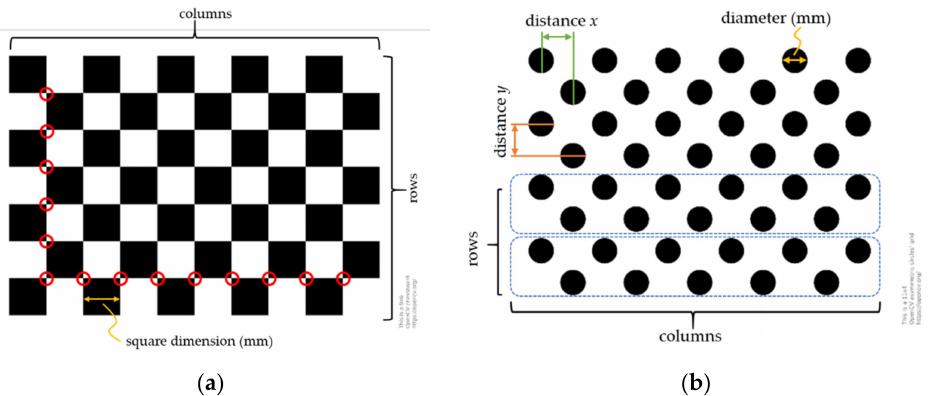
Figure 8. The most employed patterns for camera calibration. ( a ) A 7 rows × 10 columns checkerboard pattern. The calibration uses the interior vertex points of the checkerboard pattern; thus, the checkerboard in ( a ) will utilize the 6 × 9 interior vertex points (some of which are circled in red) during calibration. ( b ) A 4 rows × 11 columns asymmetrical circular grid pattern. The calibration uses the information from circles (or “blobs” in image processing terms) detection to calibrate the camera. Other planar patterns include symmetrical circular grid and ChArUco patterns (a combination of checkerboard pattern and ArUco pattern) [128,137,141]. Figures source from OpenCV and